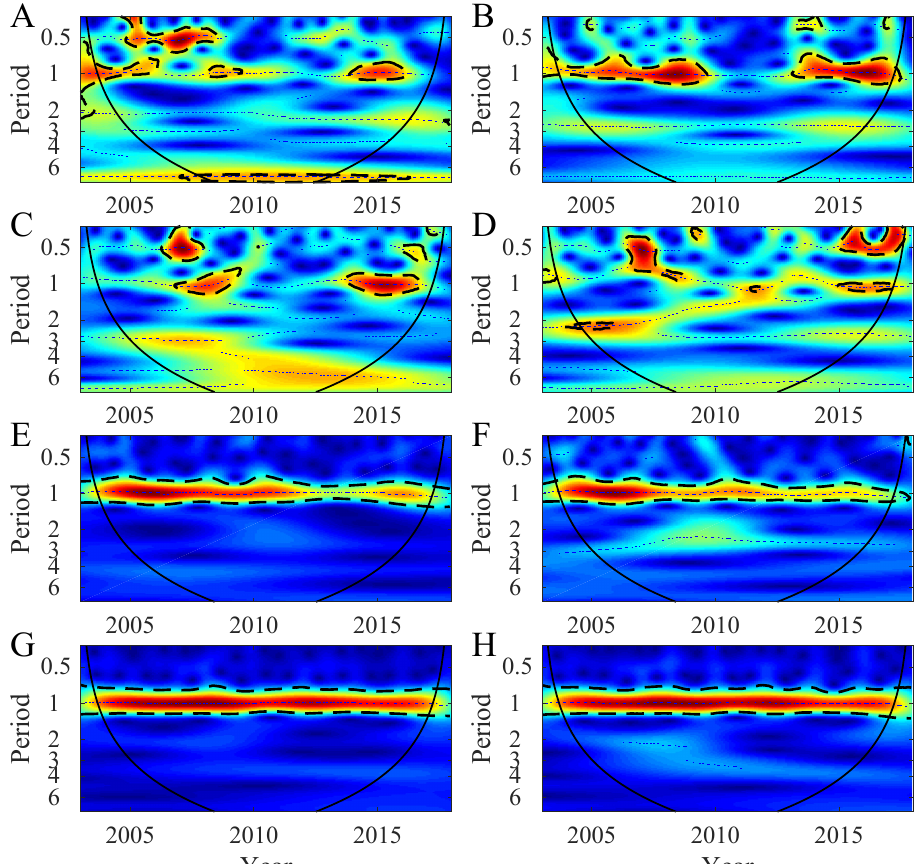
Figure 2. Wavelet Power Spectrum (WPS) showing the dominant periods (in years) of variability for the 2003–2017 time series. ( A ) Chl–a in northern area. ( B ) Chl–a in southern area. ( C ) nFLH in northern area. ( D ) nFLH in southern area. ( E ) EVI in northern area. ( F ) EVI in southern area. ( G ) SST in northern area. ( H ) SST in southern area. The black line define the cone of influence above which computations are not influenced by edge effects. The colour code for power values is graded from blue (low power) to red (high power). The black dot–dashed lines indicate the 95% and 90% significant areas obtained by adapted bootstrapping [55].